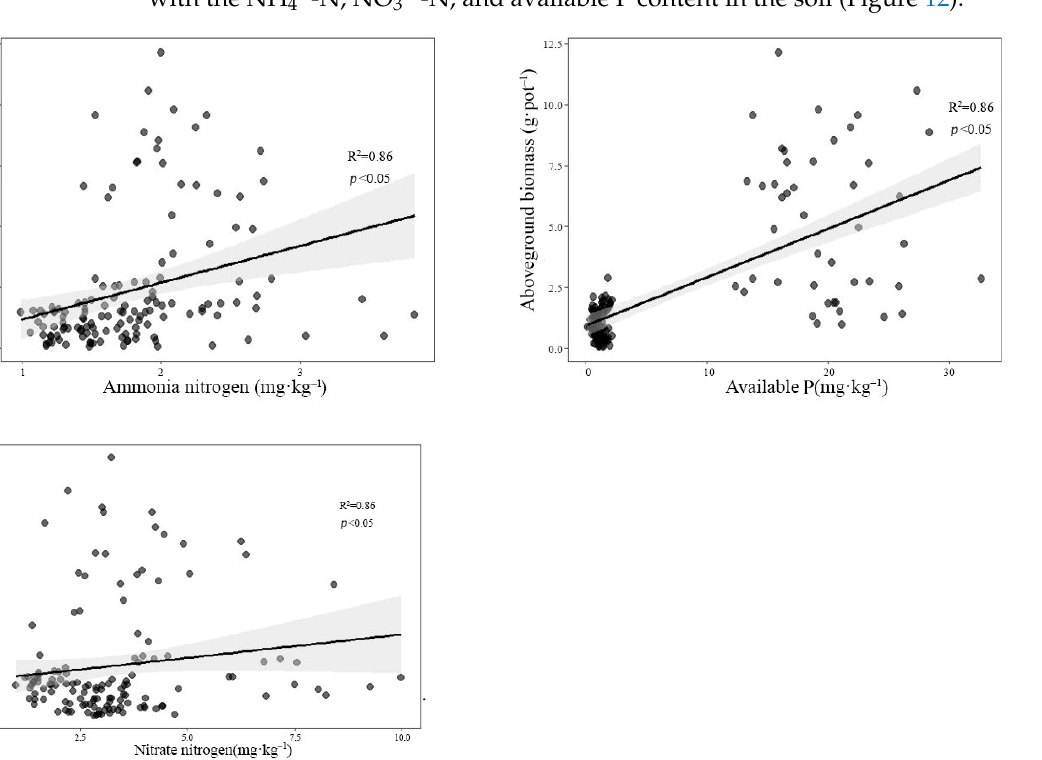
Figure 9. Effects of different treatments on soil available phosphorus content. Effects of soil type (S), planting ratio (P) and their interactions (S × P) on soil available P concentration. Different letters